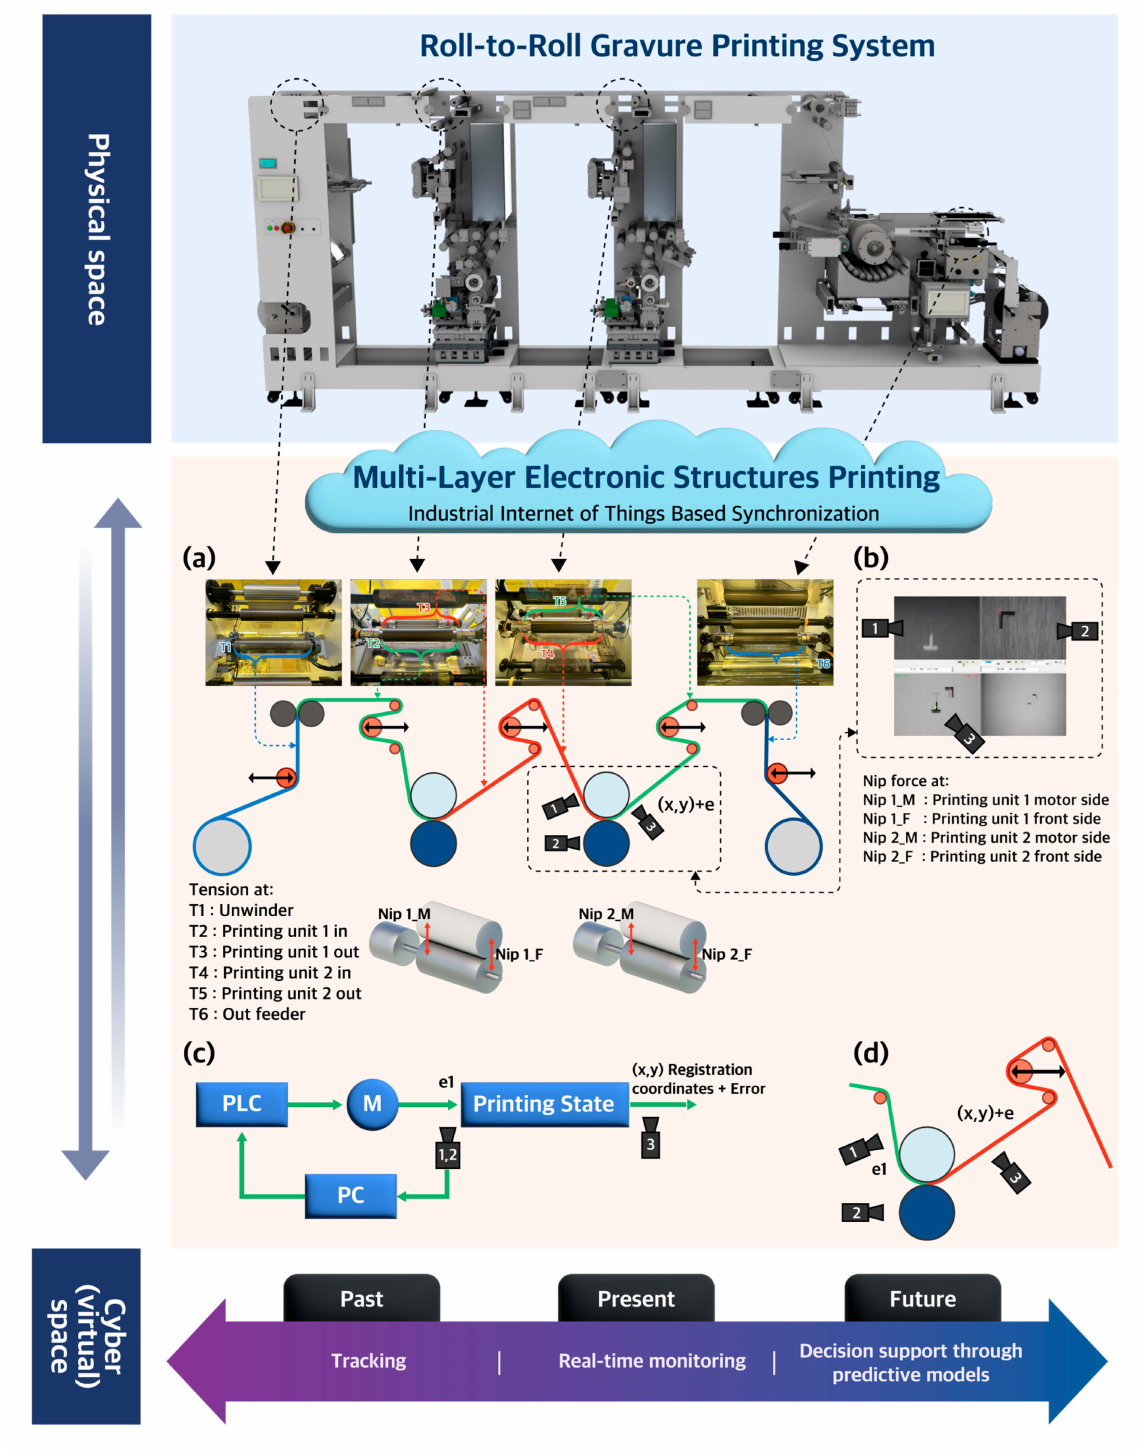
Figure 1. The conceptual map of introductory digital twin in roll-to-roll gravure (R2Rg)-based manufacturing system: ( a ) a schematic diagram of R2Rg system with all tension and nip force modules including tensions T1 to T6 and nip forces (NIP1_M, NIP1_F, NIP2_M, and NIP2_F); ( b ) a picture of the installed camera system used to measure and compensate the misalignments of the printed markers; ( c ) a block diagram for the OPRA control system; and ( d ) a camera system to monitor misalignments in printed markers between first (camera 1) and second (camera2) printing